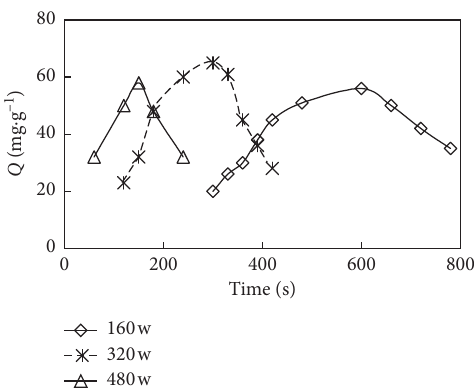
Figure 6: Effects of microwave power and irradiated time on Cu 2+ absorption